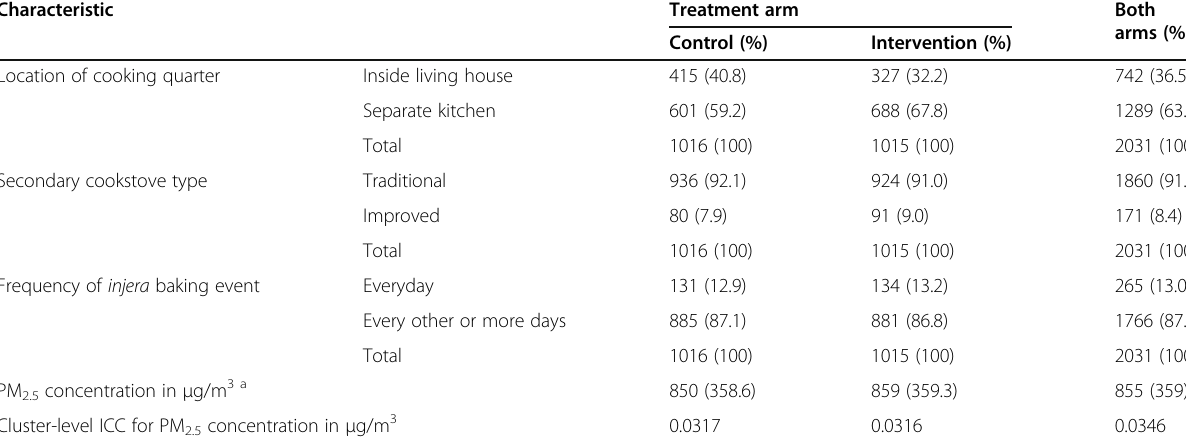
Table 1 Baseline characteristics of enrolled households